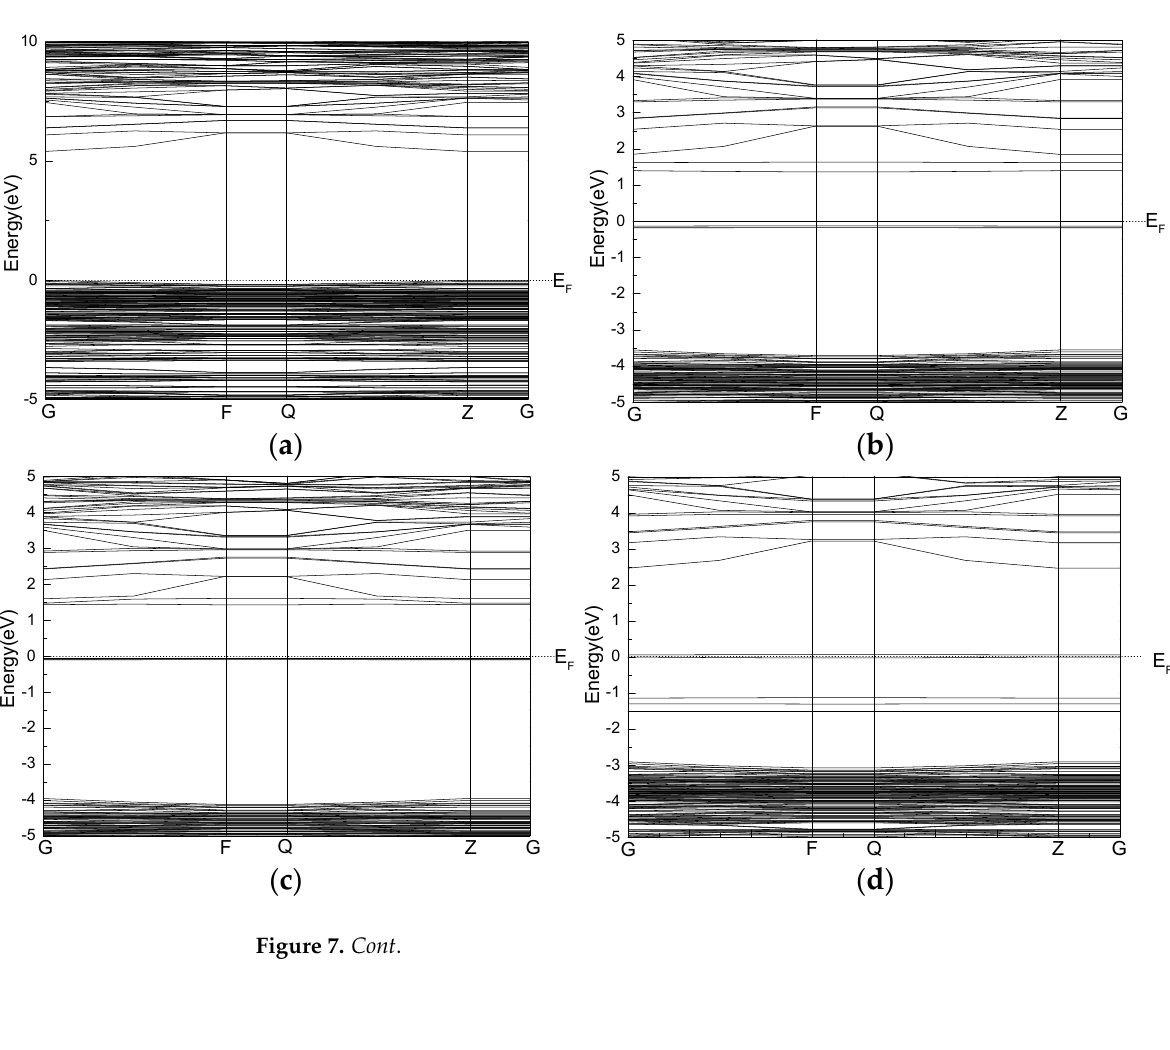
Figure 6. Schematic diagram of charge density cutting.